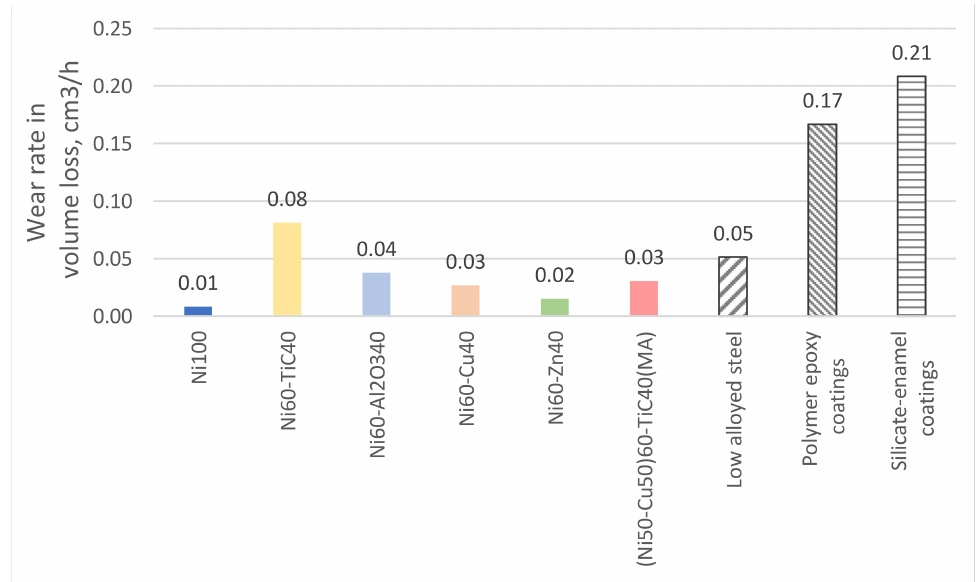
Figure 12. The rate of hydroabrasive wear of the coatings in volume loss for 0.5